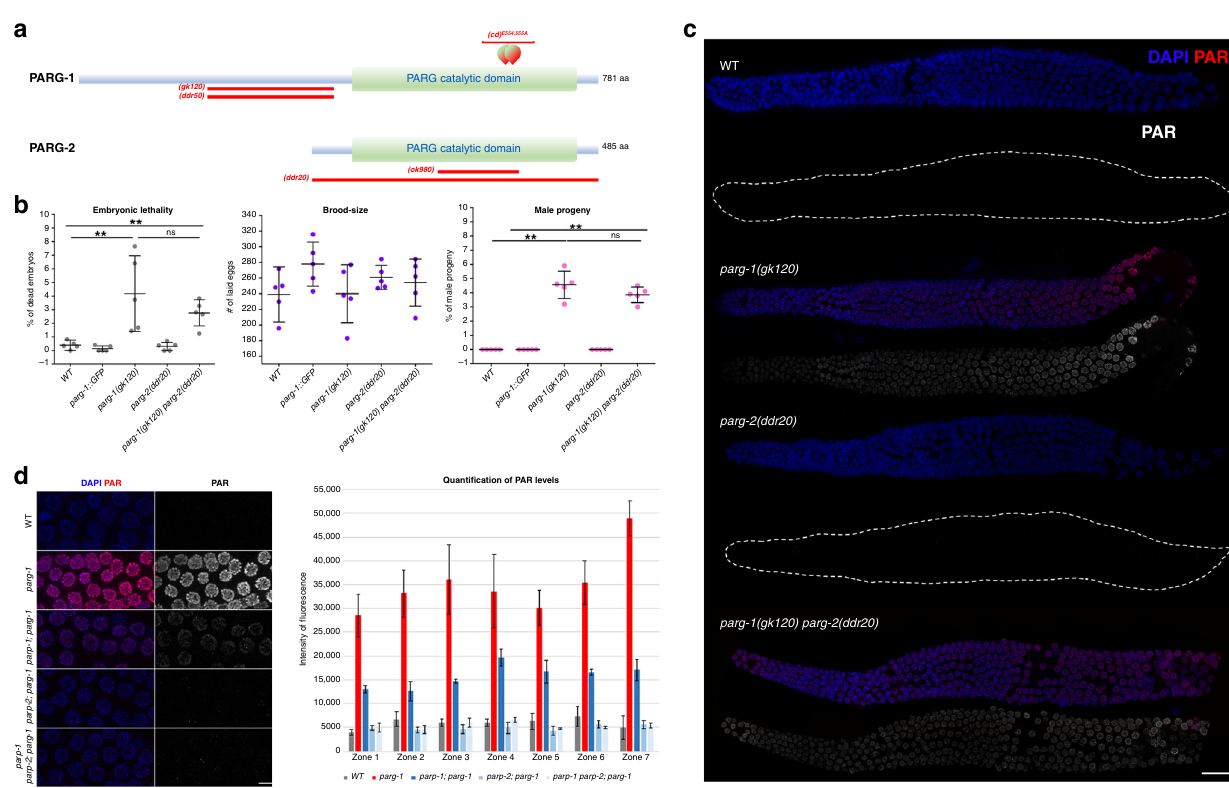
Fig. 1 PARG-1 is the main ADP-ribose glycohydrolase in C. elegans . a Schematic representation of parg-1 and parg-2 genetic loci. parg-1 is predicted to encode numerous isoforms and for simplicity only isoform A is shown. Red lines or shapes delineate the position of deletions or the point mutation in the indicated mutant alleles. b Screening of embryonic lethality, brood-size and segregation of males in the indicated genetic backgrounds. Center of error bars indicates mean. Number of embryos scored: WT ( n = 5, 1196), parg-1::GFP ( n = 5, 1389), parg-1(gk120) ( n = 5, 1200), parg-2(ddr20) ( n = 5, 1304), and parg-1(gk120) parg-2(ddr20) ( n = 5, 1271). Error bars indicate standard deviation, **p < 0.0001 assessed by unpaired t test and ns = not signi fi cant. c Representative images of whole-mount gonads from indicated genotypes showing detection of PAR by immuno fl uorescence. Scale bar 20 μ m. Analysis was performed in biological duplicates. d Left: representative pictures of late pachytene nuclei from indicated genotypes showing parp-1- and parp-2 - dependent accumulation of PAR in parg-1 mutants. Gonads were divided into seven zones, encompassing the region from the distal tip cell to diplotene. Scale bar 5 μ m. Right: quanti fi cation of PAR detected by immuno fl uorescence. Chart reports mean fl uorescence intensity from at least two gonads/ genotype. Error bars indicate standard deviation. Number of nuclei scored was (from zone 1 to 7): WT (97, 129, 115, 107, 102, 74, 45), parg-1(gk120) (129, 136, 140, 129, 130, 96, 82), parp-1(ddr31); parg-1(gk120) (93, 113, 123, 129, 102, 69, 44), parp-2(ok344); parg-1 (190, 263, 215, 179, 179, 125, 72), parp-1 (ddr31); parp-2(ok344); parg-1(gk120) (107, 140, 134, 144, 126, 103,